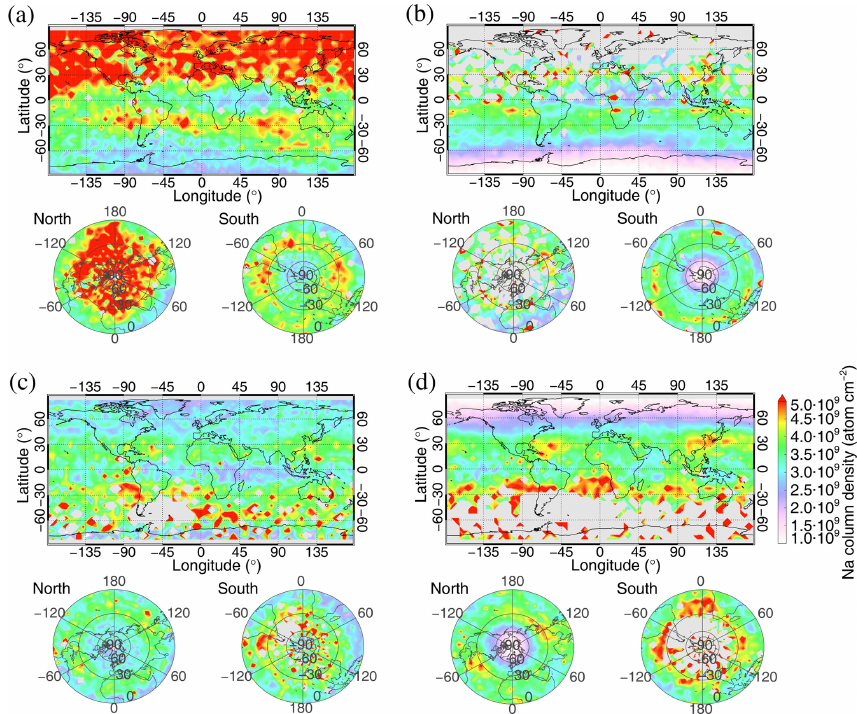
Figure 5. Seasonal variations in the Na column number density from the OSIRIS limb-scanning radiance measurements made by the Odin satellite during the period 2004 to 2009, with a spatial resolution of a 5 ◦ × 5 ◦ grid. Maps for (a) autumn (September, October, November), (b) winter (December, January, February), (c) spring (March, April, May), and (d) summer (June, July, August). It is worth emphasising that the grey-shaded areas represent the areas where the OSIRIS limb-scanning radiance measurements were not made during the dark winter months at high latitudes, but these areas should have a winter maximum of Na column number density as indicated by the seasonal variations in Na layers from the ground-based lidar